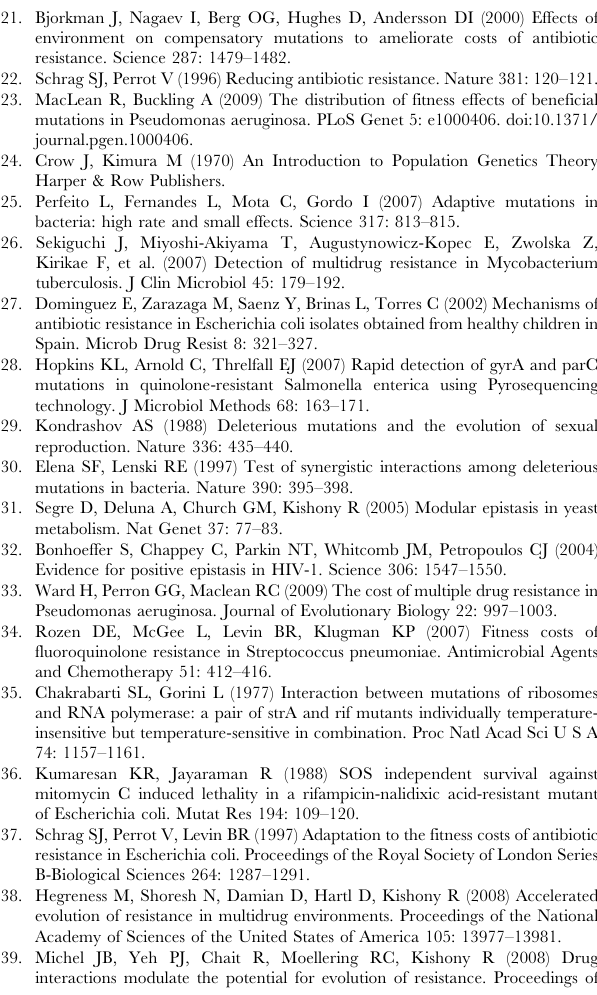
Table S1 Genotypes and costs of single resistant mutations.